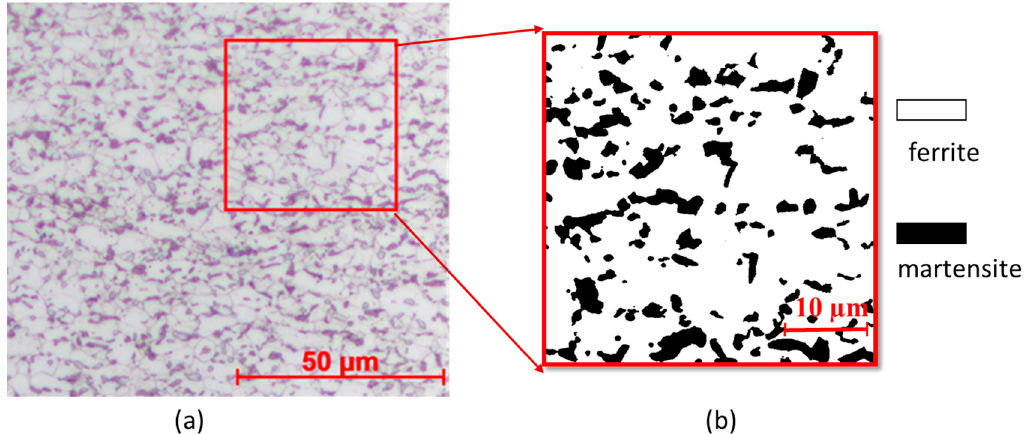
Figure 4. ( a ) Microstructure of DP600 steel and ( b ) selection of finite element mesh of representative volume element (RVE).